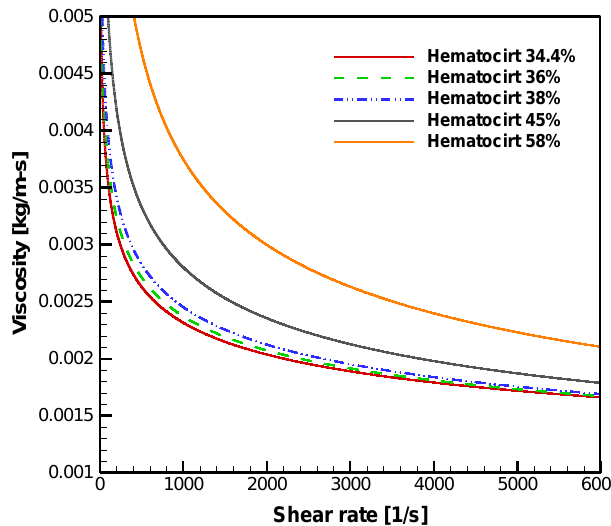
Figure 2. Viscosity distribution with hematocrit.